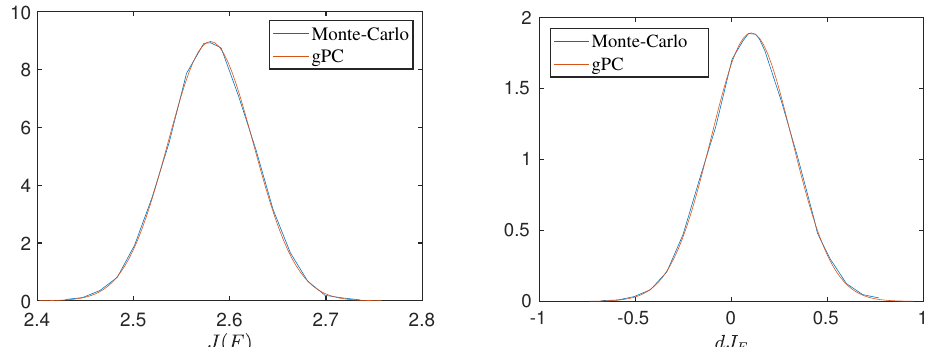
Figure 8. Probability Density Function (PDF) comparison between Monte–Carlo ( N = 10000 samples) and gPC ( c = 4). Left: PDF of (32). Right: PDF of the sensitivity of Equation (32) w.r.t. F . The PDF from the Monte–Carlo is approximated by evaluating the histogram and connecting the bin midpoints. Here, T = 100 and N =